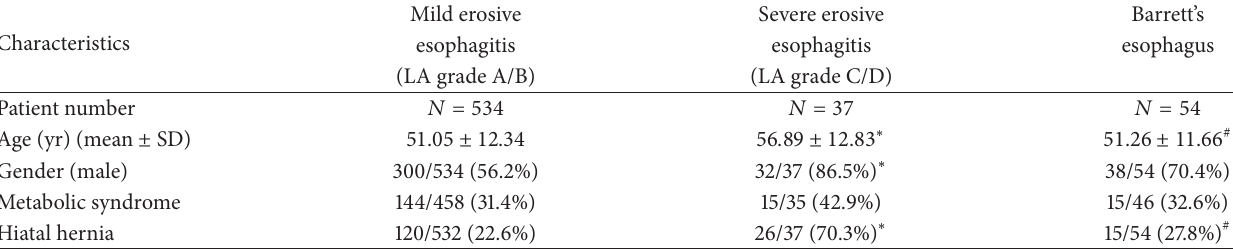
Table 1: Demographic data of patients with mild erosive esophagitis, severe esophagitis, and Barrett’s esophagus. Characteristics